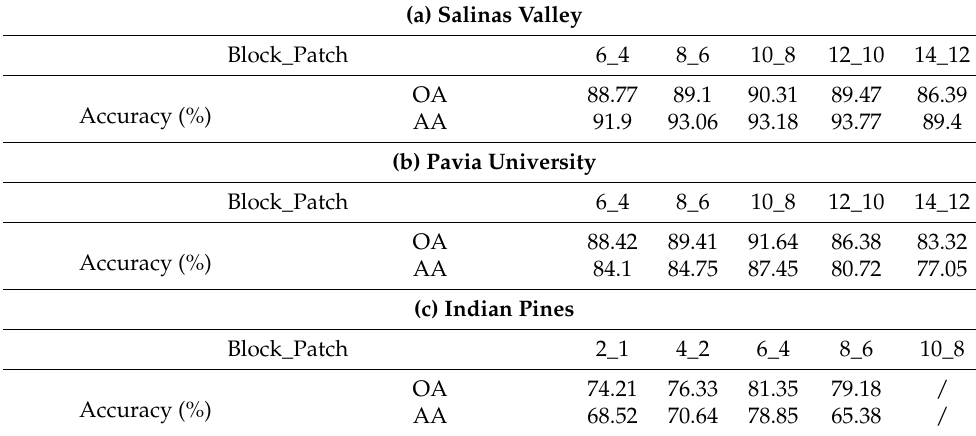
Table 8. Effect of the block-patch size on OA & AA (%): (a) Salinas Valley, (b) Pavia University, and (c) Indian Pines.